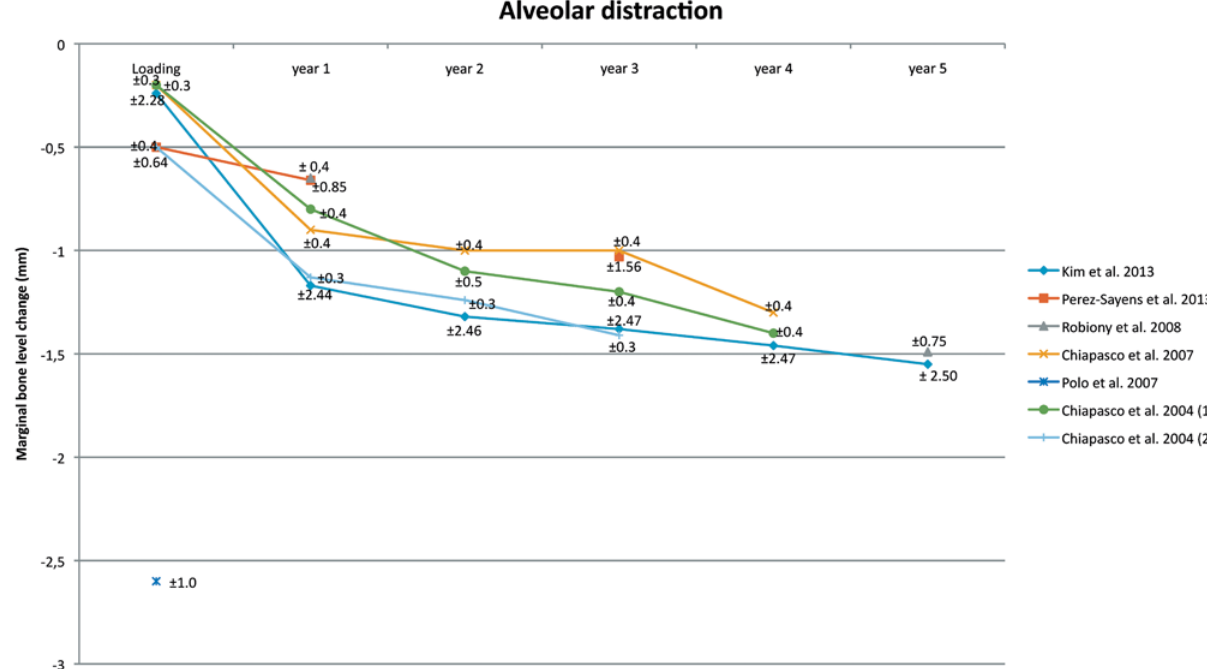
Figure 3- Alveolar distraction. Mean and Standard Deviation are indicated